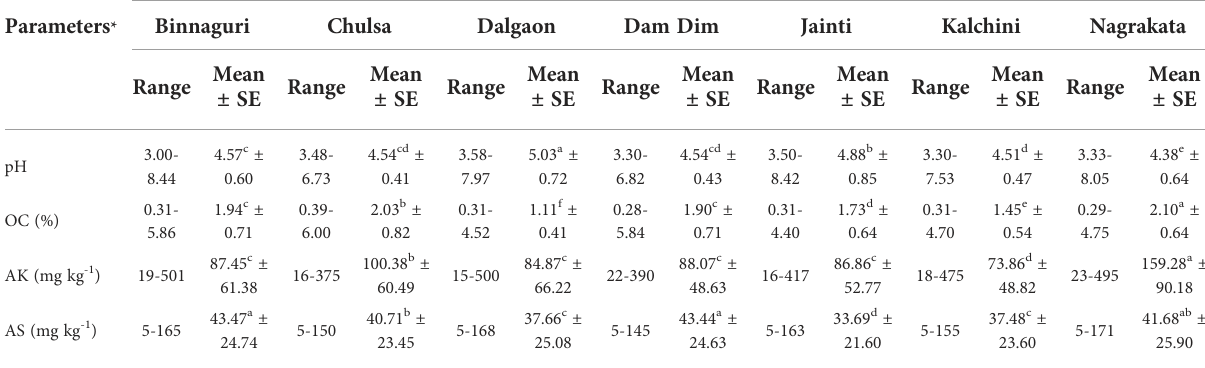
Name of the sub-districts